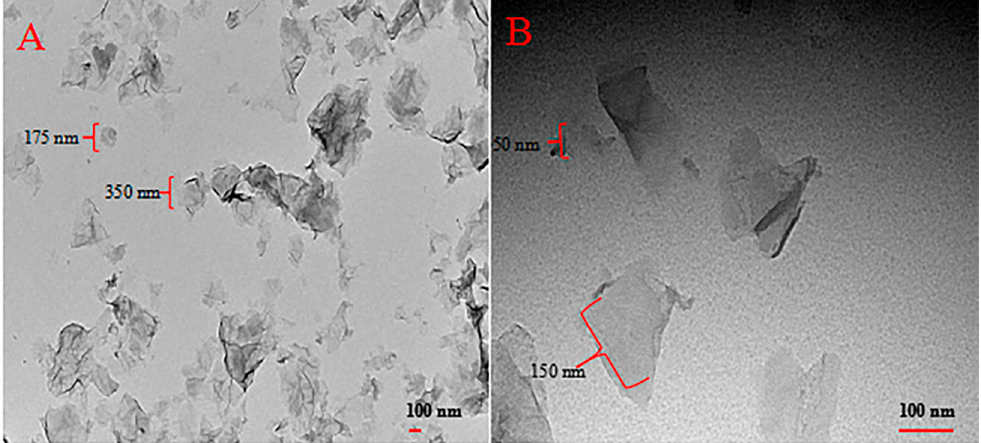
Figure 3. Transmission electron microscopy (TEM) images of the GO ( A ) and GRcR ( B ). (Scale bar: 100 nm).